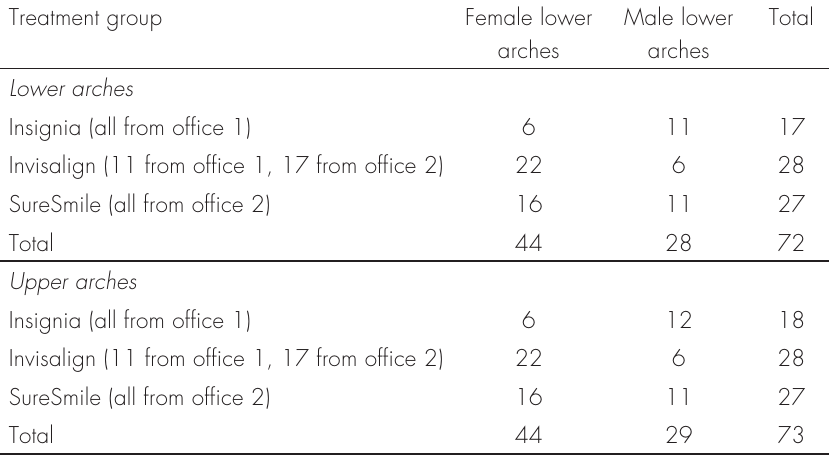
Table II. Lower and upper arch gender distribution.